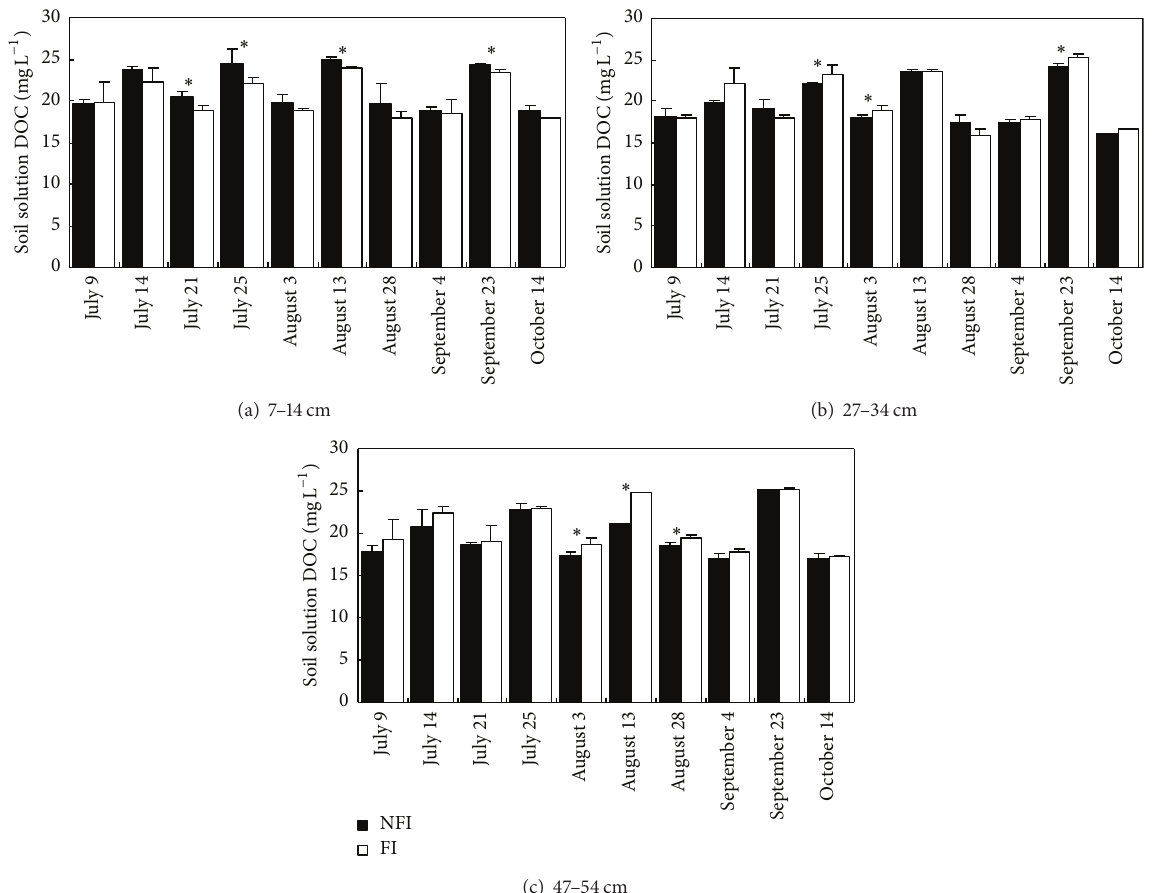
Figure 4: Dissolved organic carbon (DOC) concentrations in paddy soil solutions at different depths under different irrigation managements ( ∗ indicates difference between NFI and FI that is significant at 𝑃 < 0.05